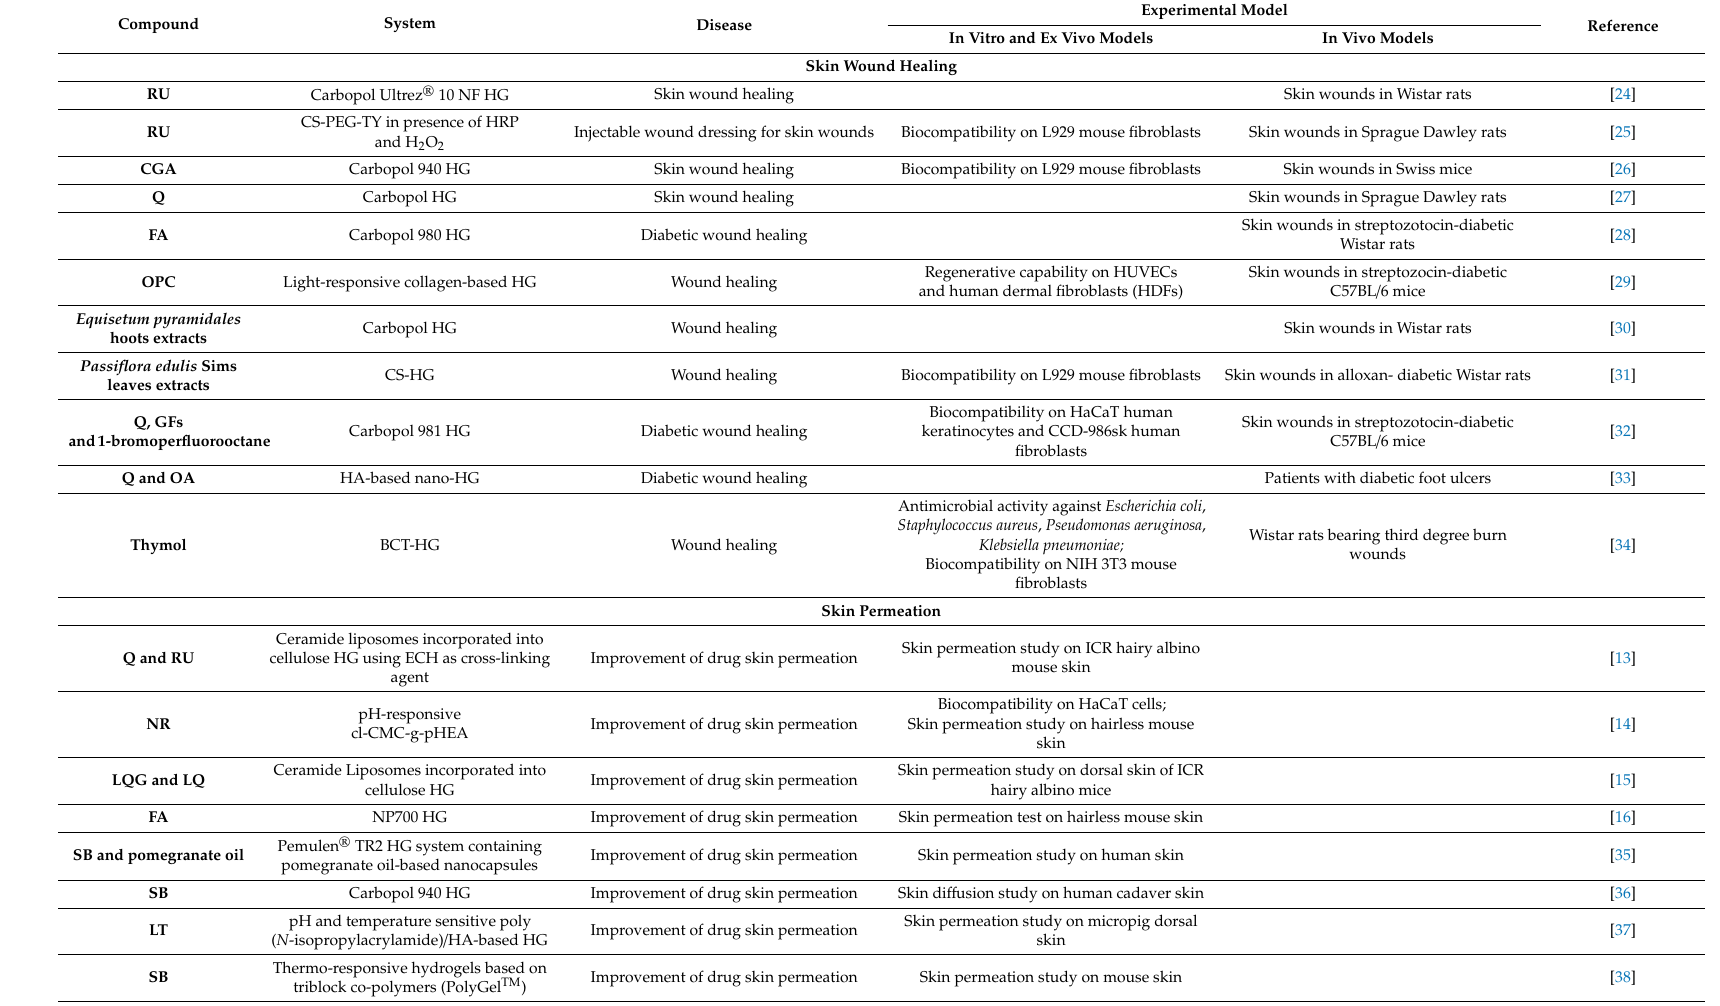
Table 1. Hydrogels for the delivery of plant-derived